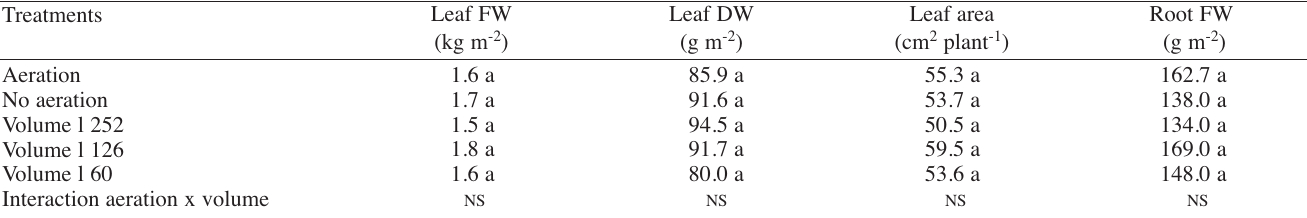
Table 1 - Effect of aeration and volume (l per m 2 of cultivated area) of the nutrient solution on leaf production (leaf FW and leaf DW), leaf area and root production (root FW) in spinach grown in a floating system in the summer season